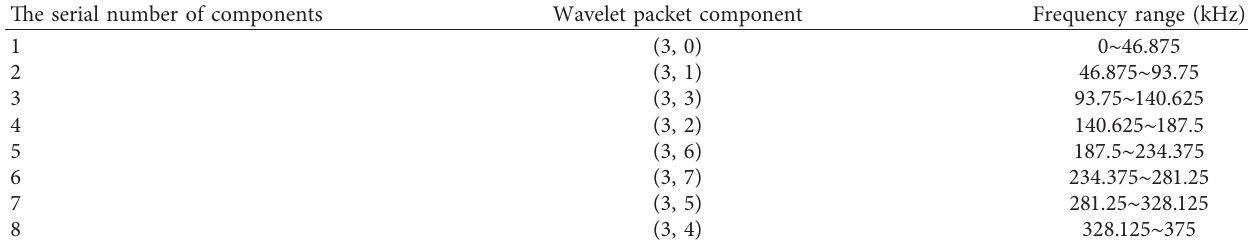
Table 3: Wavelet packet component reconstruction signal spectrum